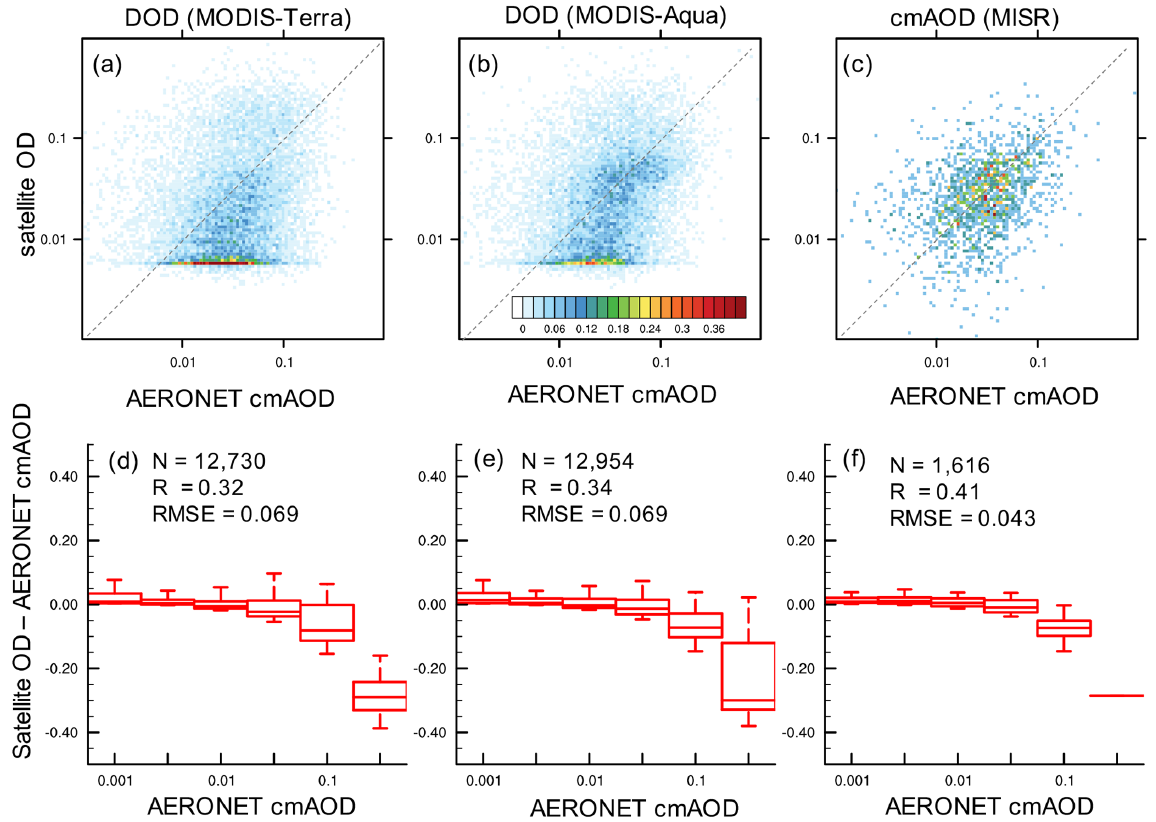
Figure 5. Comparison of MODIS DOD and MISR cmAOD against colocated AERONET cmAOD. (a–c) Joint probability density (%) of colocated cmAOD from AERONET and (a) DOD from MODIS-Terra, (b) DOD from MODIS-Aqua, and (c) cmAOD from MISR. (d–f) Boxplot of the difference in colocated measurements between (d) DOD from MODIS-Terra, (b) DOD from MODIS-Aqua, and (c) cmAOD from MISR and cmAOD from AERONET, as a function of AERONET cmAOD. The boxplots show the 5th, 25th, 50th, 75th, and 95th percentiles of the DOD difference. The sample size ( N ), correlation coefficients ( R ), and root-mean-square error (RMSE) with colocated AERONET cmAOD are provided in (d–f) for the corresponding satellite